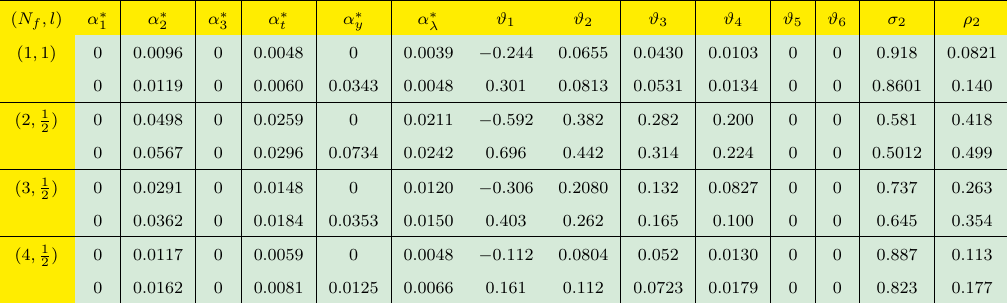
and (cid:26) (see 2 2